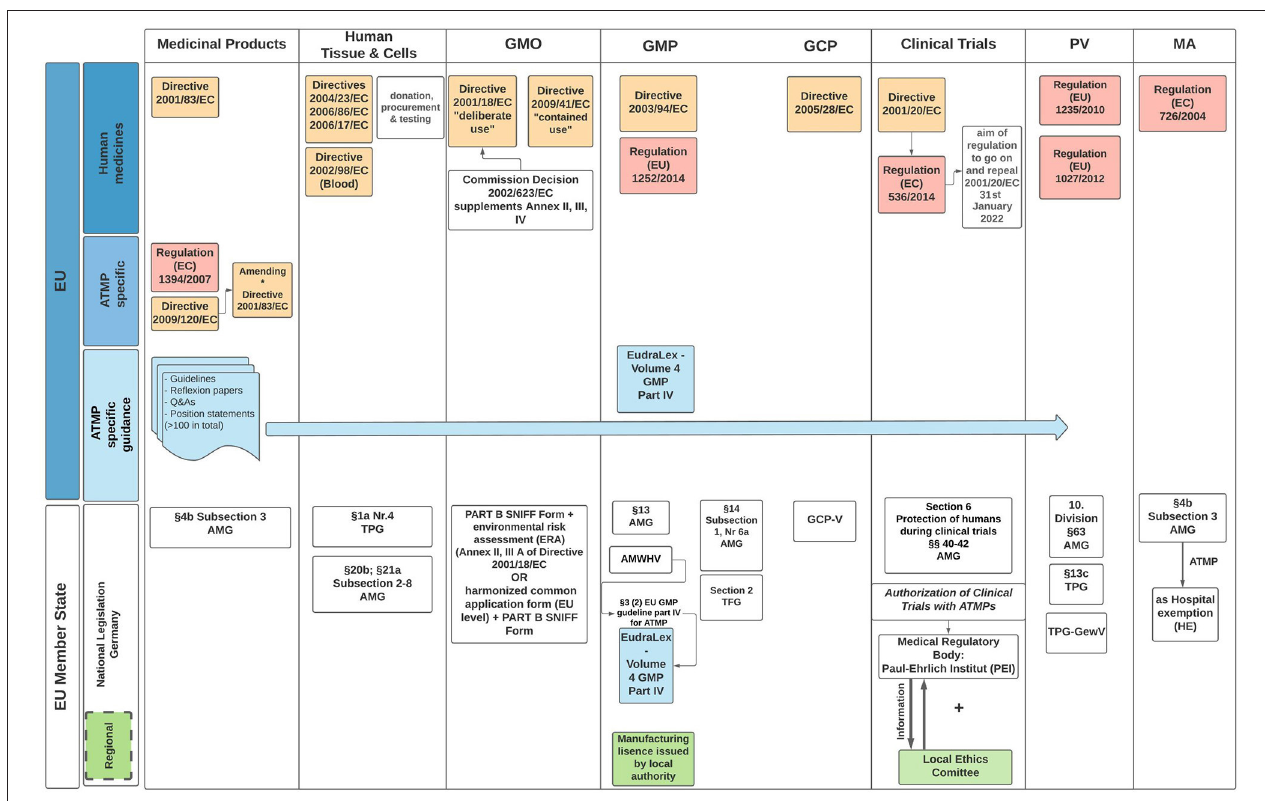
FIGURE 2 | EU and German regulatory framework for ATMP specific legislation. The diagram outlines the directives EU Member States (MS) must enact, with particular reference to the regulatory guidelines applicable when seeking IMP authorization in Germany. Governance and oversight of clinical trials is the responsibility of the MS undertaking the trial. In Germany, regional authorities of the federal states are responsible for issuing a manufacturing approval. Clinical Trial authorization takes place with agreement of the local Ethics Committee. AMG, arzneimittelgesetz ( Engl. German drug law); TPG, transplantationsgesetz ( Engl . transplantation law); TPG-GewV, TPG—Gewebeverordnung ( Engl. tissue regulation); TFG, transfusionsgesetz ( Engl. Transfusion law); AMWHV, arzneimittel- und wirkstoffherstellungsverordnung ( Engl . ordinance for the manufacture of medicinal products and active pharmaceutical ingredients); GMO, genetically